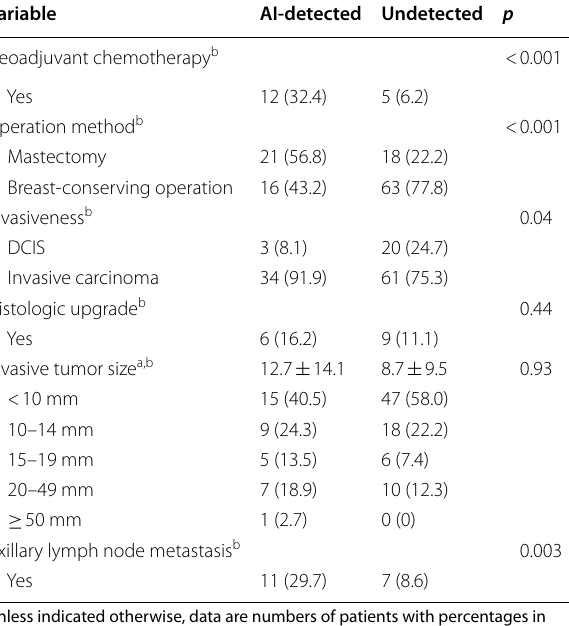
Table 2 Characteristics of mammographically occult